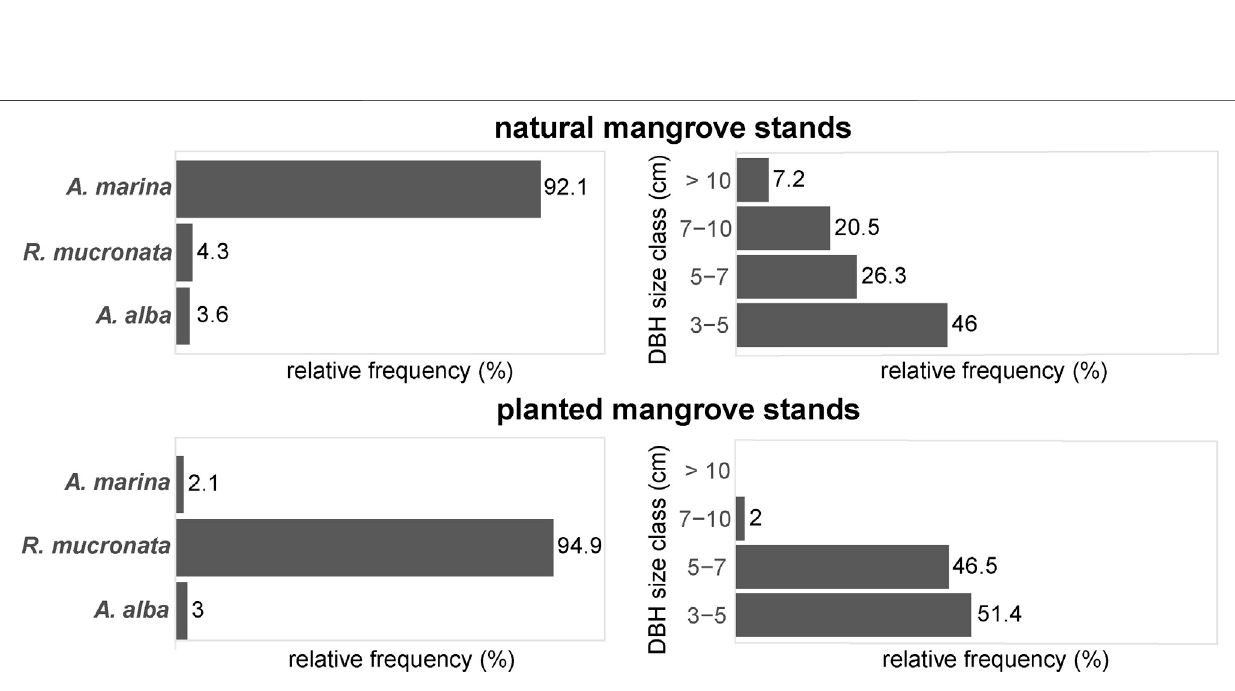
Frontiers in Environmental Science |